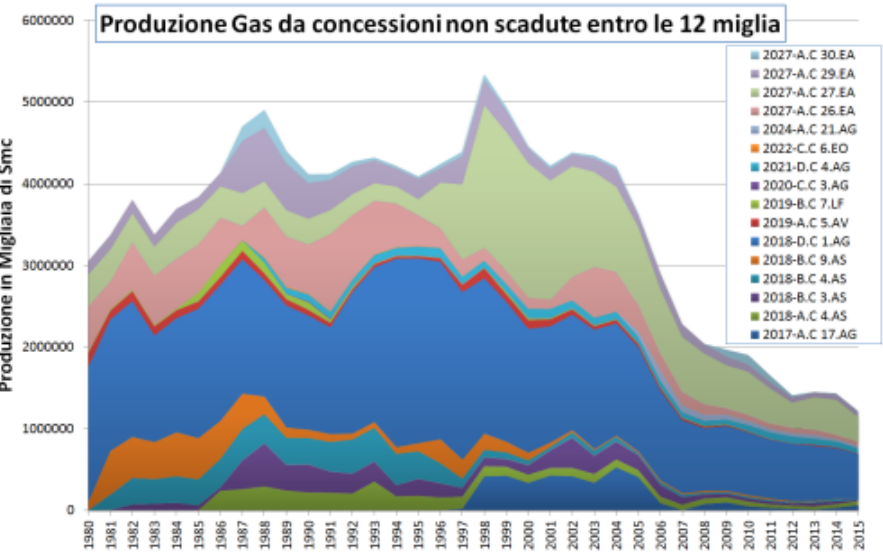
Figure 2. Production of natural gas from concessions located within 12 miles, still operative. The box on the right reports the concession code and the year when the license will expire [1].